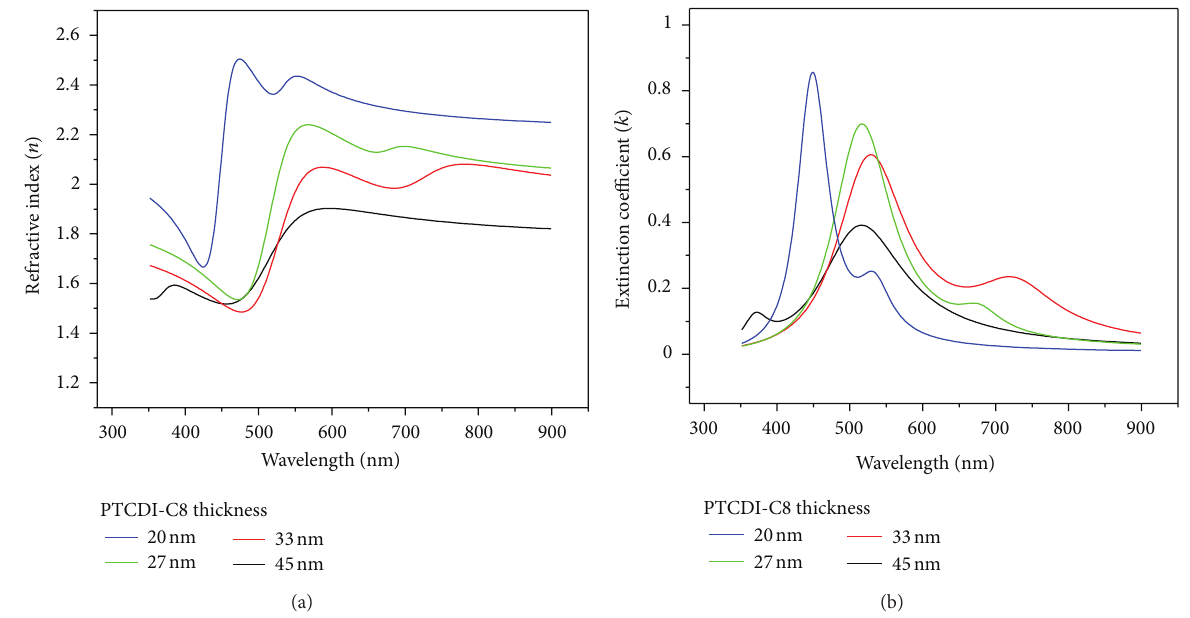
Figure 7: The (a) refractive indices ( 𝑛 ) and (b) extinction coefficients ( 𝑘 ) for PTCDI-C8 films with different thicknesses.